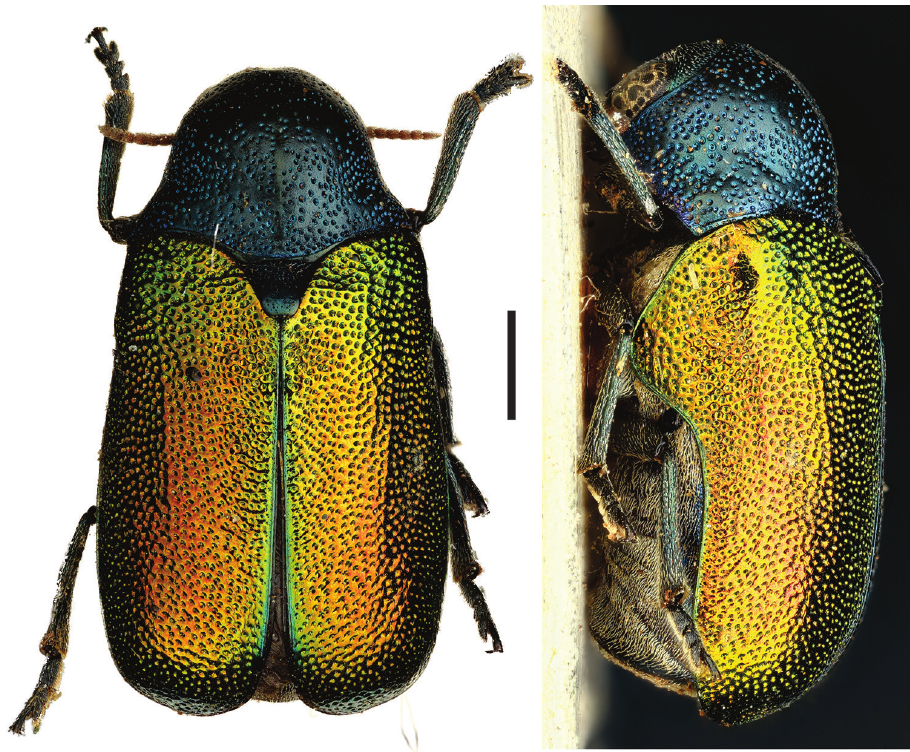
Figure 16. Ischiopachys cribipennis cribipennis Lacordaire (2) , left: habitus (dorsal view), right: habitus (lateral